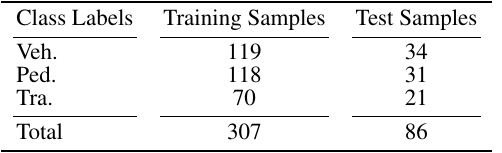
Table 1. Overview of real training and test samples obtained from Sydney